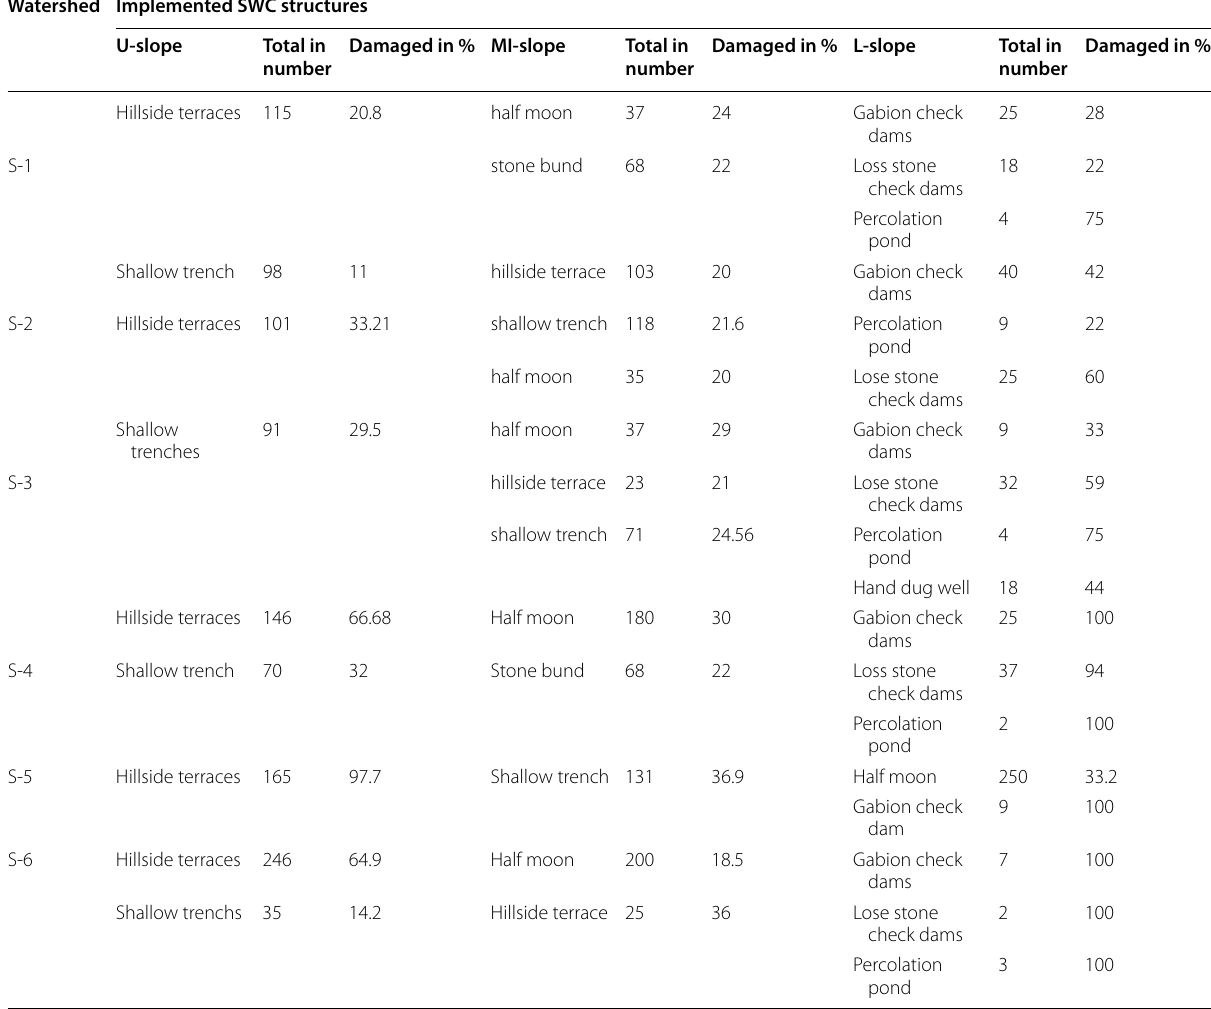
U-slope upper slope; Ml-slope middle slope, L-slope lower slope; S-1 Adikesho, S-2 Deberewahabit, S-3 Gemad, S-4 Debretsion, S-5 Laelay-Wukro, S-6 Tsigerda